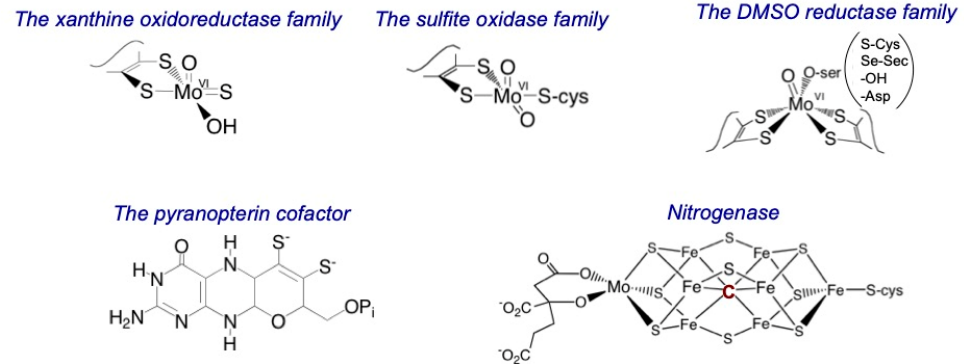
Figure 1. The families of molybdenum ‐ containing enzymes.